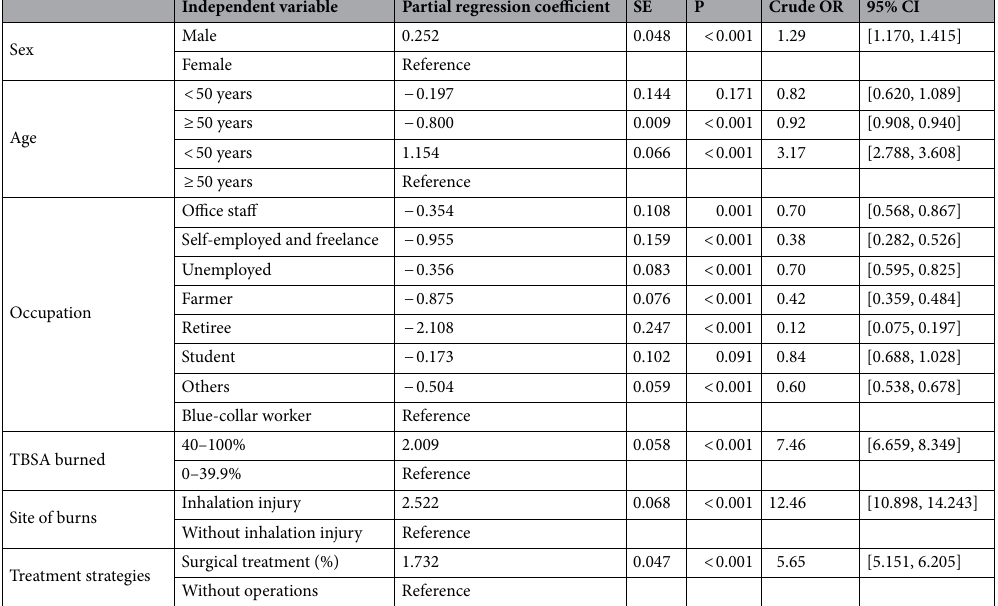
Table 2. Univariate regression analyses for scar contracture-associated re-hospitalisation among burn inpatients. OR odds ratio, CI confidence